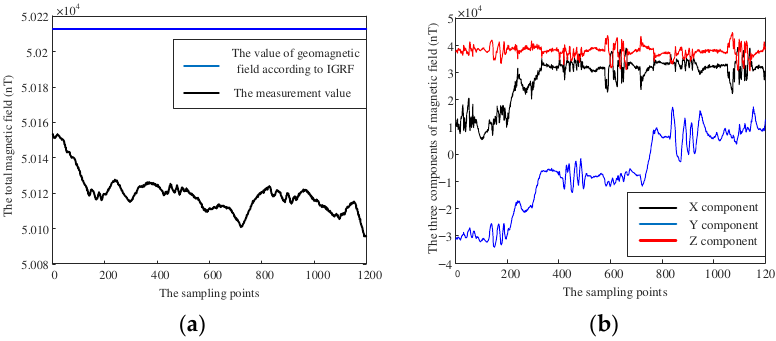
Figure 5. The measurement results of inertial navigation sensor.